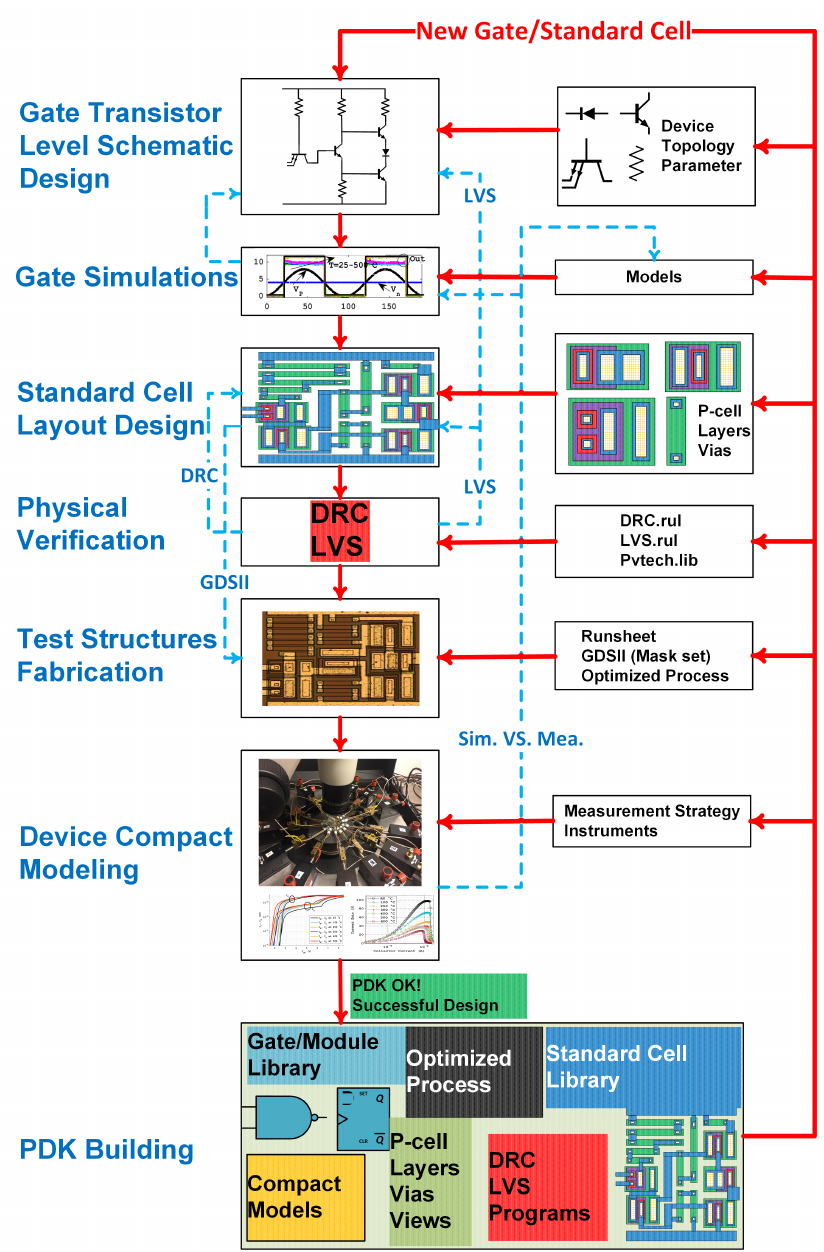
Figure 1. Flowchart summarizing the PDK building process for in-house SiC bipolar low-voltage technology. The feedback provided by the characterization of the devices and circuits to models, simulations, design and fabrication is highlighted by blue arrows (dotted lines), whereas boxes and red arrow indicate steps for the PDK development. The PDK gate schematic is designed using the PDK devices symbols in Cadence Virtuoso Analog Design Environment (ADE). After successful simulations at transistor level using Cadence Spectre simulator, the standard cell physical implementation was carried out in the Cadence Virtuoso ADE. To ensure the correct signal and power routing the design rule check (DRC) layout versus schematic (LVS) programs were created by the Cadence supported physical verification system (PVS) tool. The mask set and process runsheet was used to fabricate the standard cells and devices test structures in the low-voltage SiC bipolar process. The fabricated test structures were measured on wafer. The HT models for the SiC BJTs were created and used for the schematic transistor level